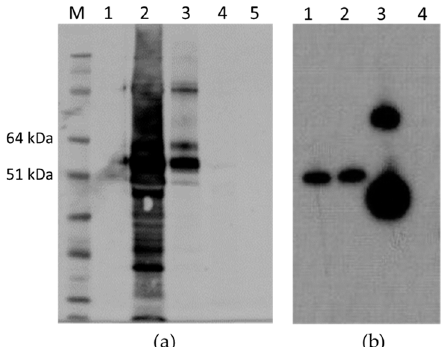
. Figure 7. ( a ) Western blot with anti-M2e mAb; M. Molecular weight marker (kDa); 1. Empty pEAQ- HT ; 2. TSP extracted from M2 HEV 110–610; 3. Gradient purified M2 HEV 110–610 protein; 4. TSP extracted from HEV 110–610 crude extract; 5. HEV 110–610 after purification; ( b ). Western blot with anti-M2e mAb of TSP purified from different chimeric constructs; 1. M2 HEV 33–610; 2. M2 HEV 1– 610; 3. M2 HEV 110–610 and 4. Empty pEAQ- HT .